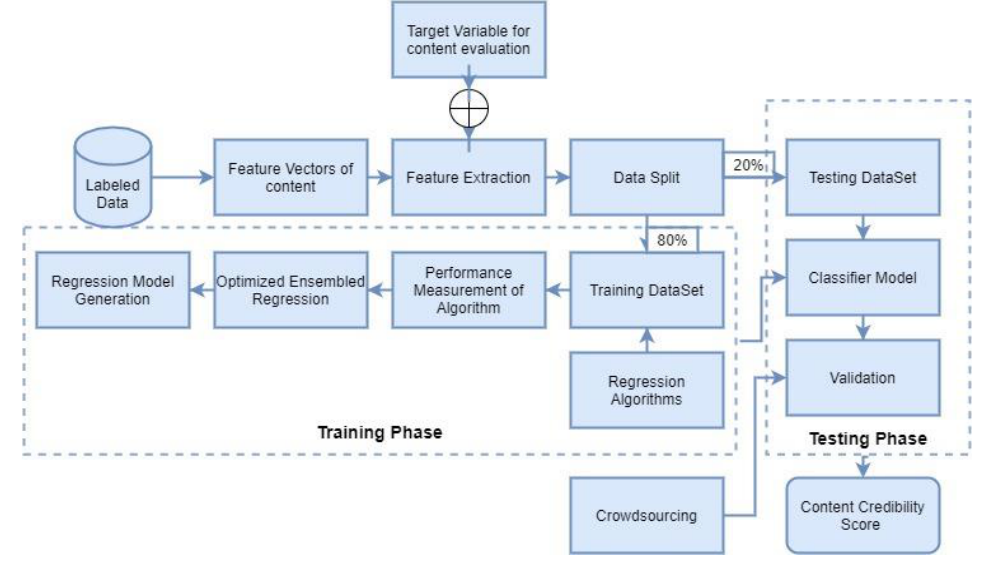
Figure 1. System prototype for content modeling.